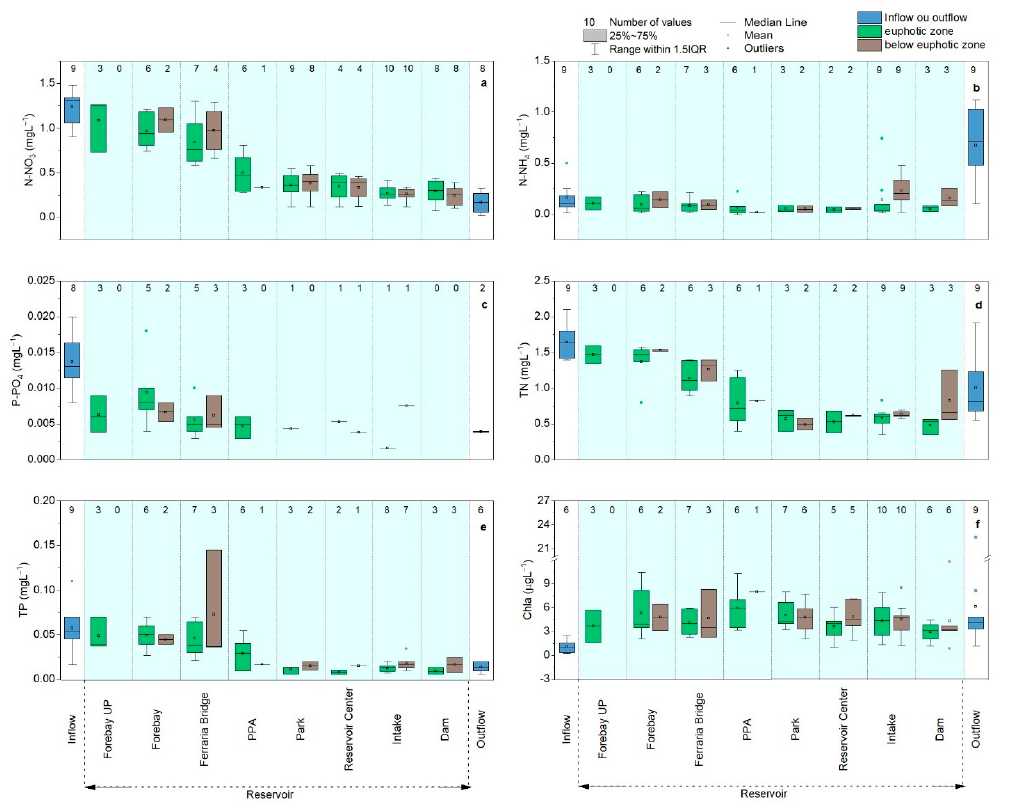
Figure 3. Box plots of water quality data estimated through laboratorial analysis and sensor measurements during all sampling campaigns at different locations along the reservoir (from inflow to outflow, see Figure 1 for the location of sampling sites). Data from different sampling sites are separated by vertical gray lines. Blue boxplots show measurements in the inflow and outflow; green boxplots show data from within the euphotic zone; and grey boxplots show data from below the euphotic zone. Numbers on the top of each boxplot represent total of samples; see the legend for an explanation of the box plot elements. Each panel presents one parameter indicated in each y -axis. Each panel presents the concentration of one substance: ( a ) N-NO 3 ; ( b ) N-NO 4 ; ( c ) P-PO 4 ; ( d ) TN; ( e ) TP; and ( f ) chla.